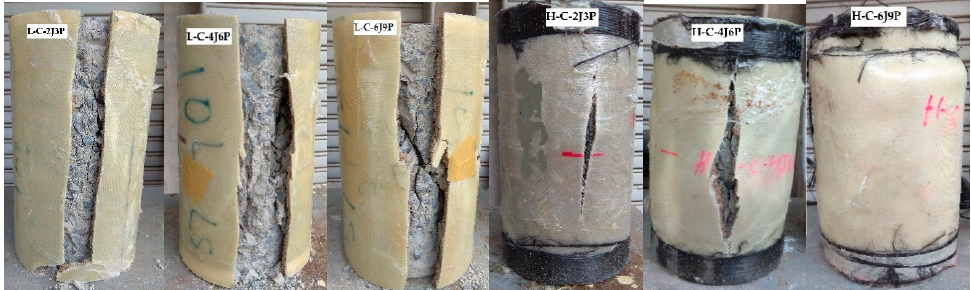
Figure 8. Failure modes of low- and high-strength circular columns.